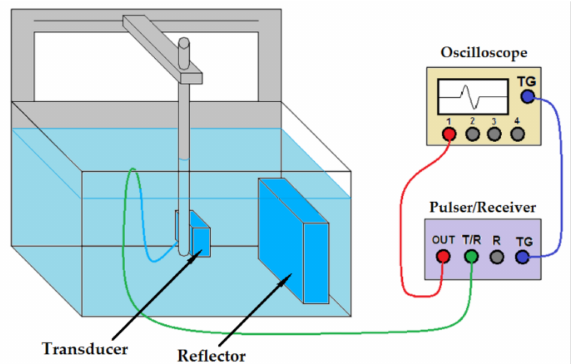
Figure 13. Schematic diagram of the pulse-echo